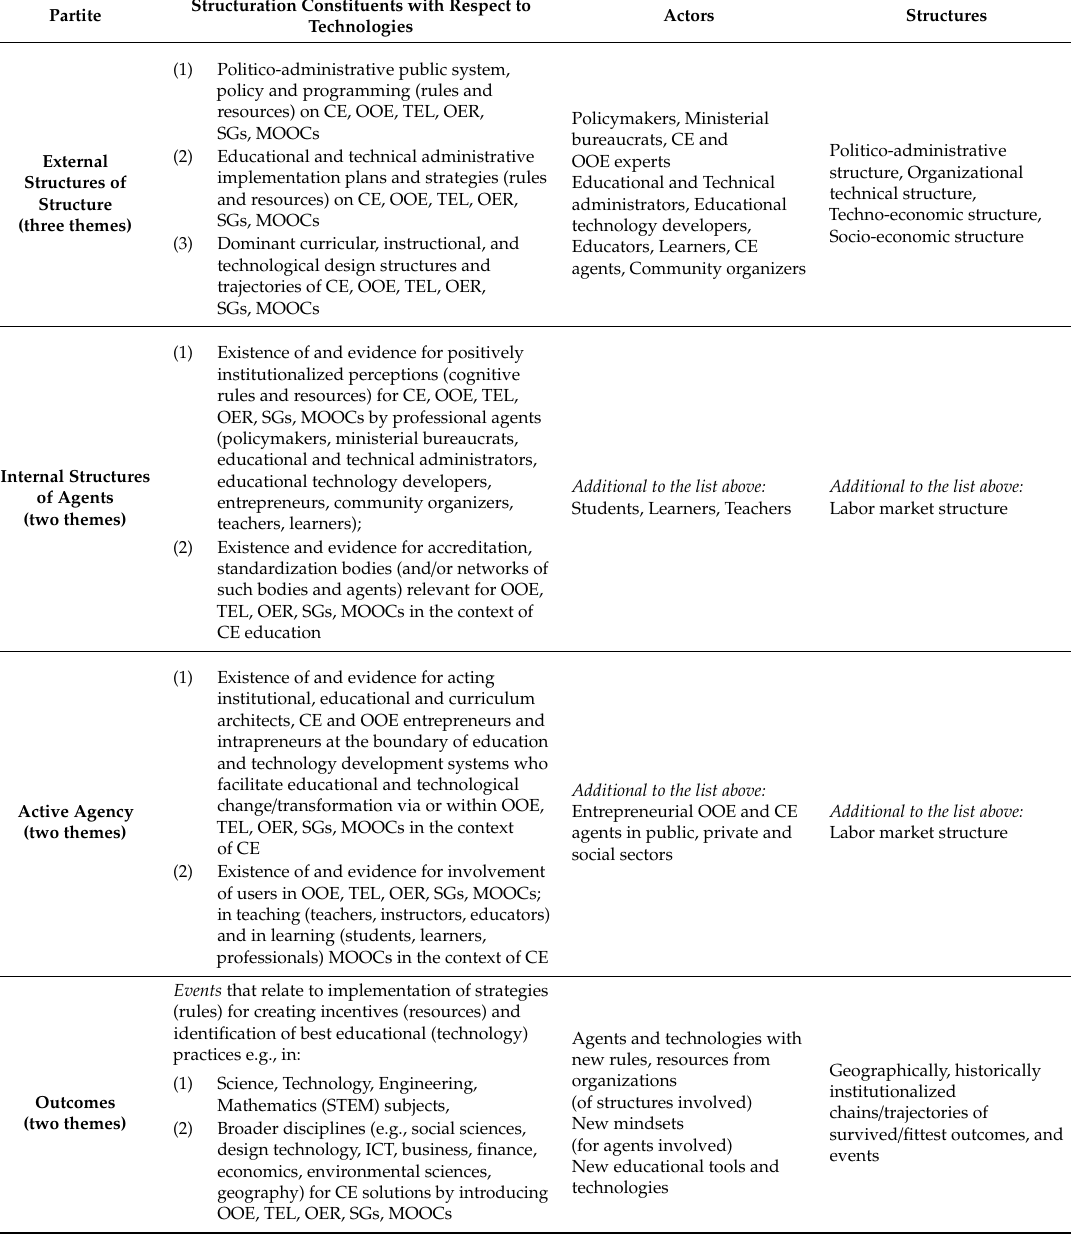
Table 4. Structuration dynamics among actors, structures and